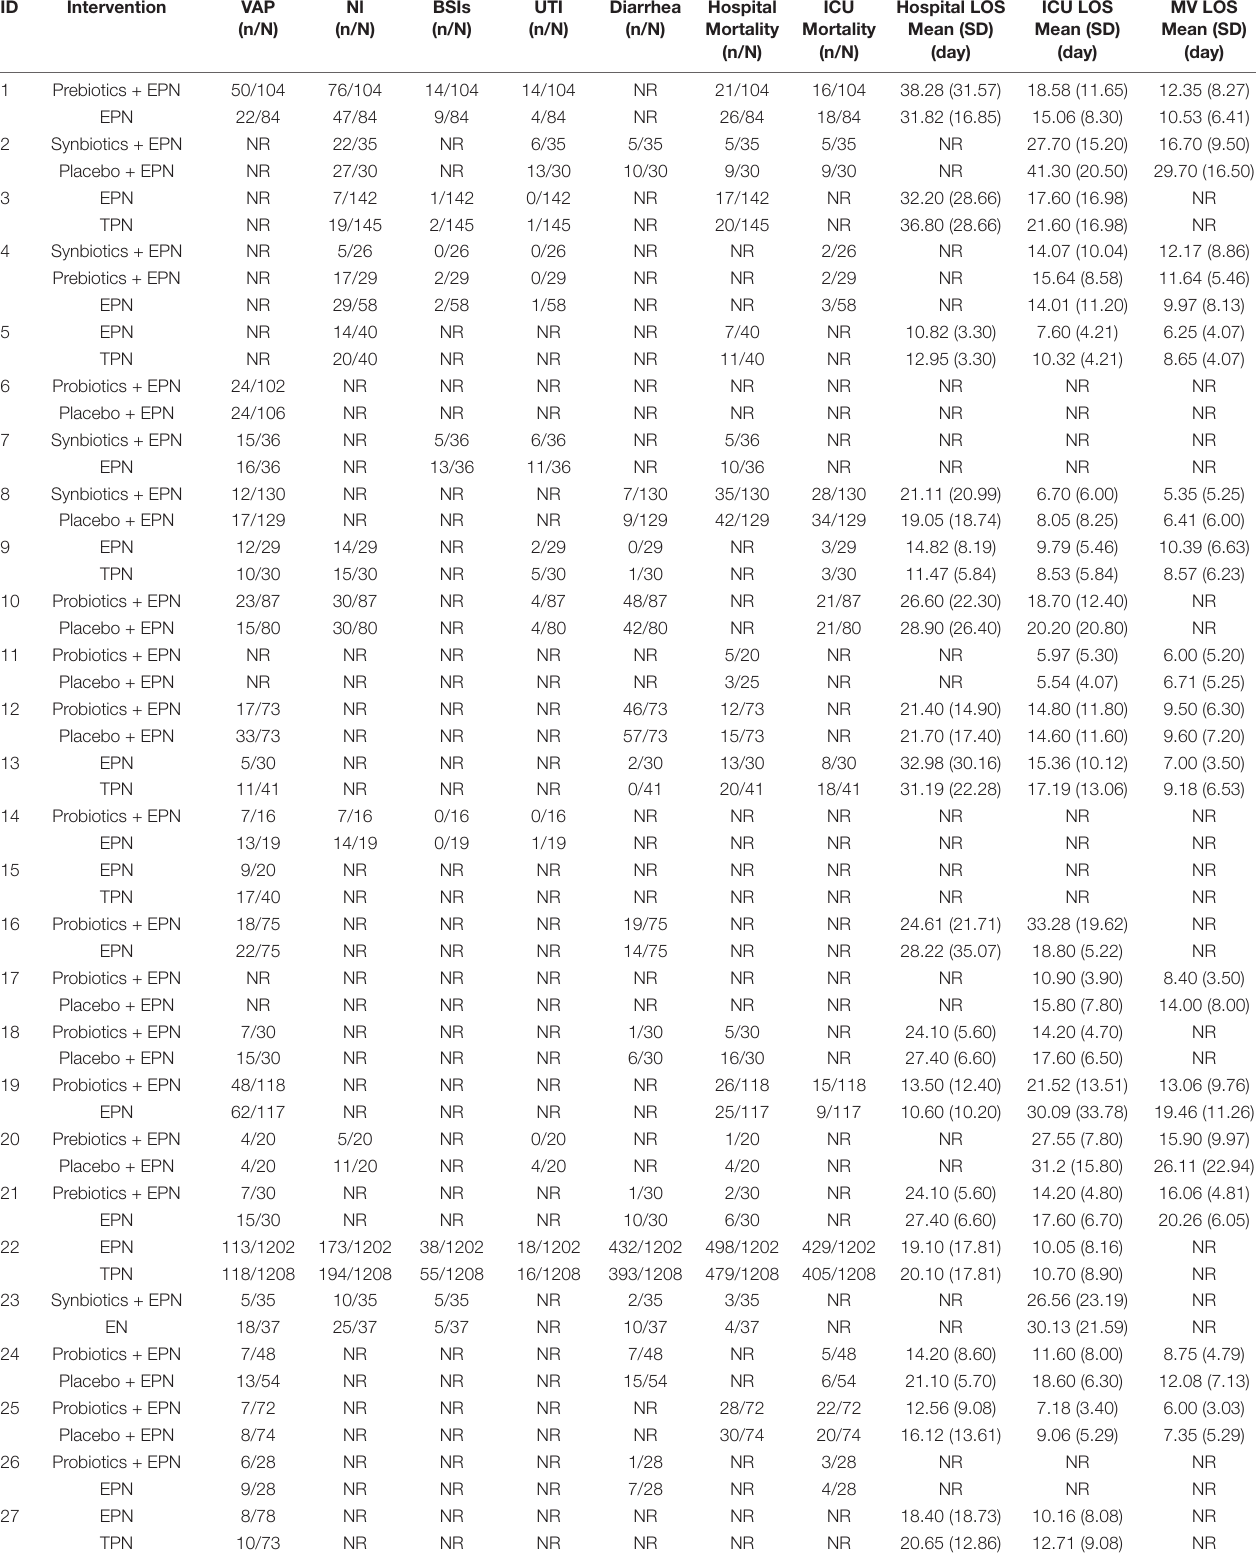
TABLE 3 | Reported clinical outcomes of included